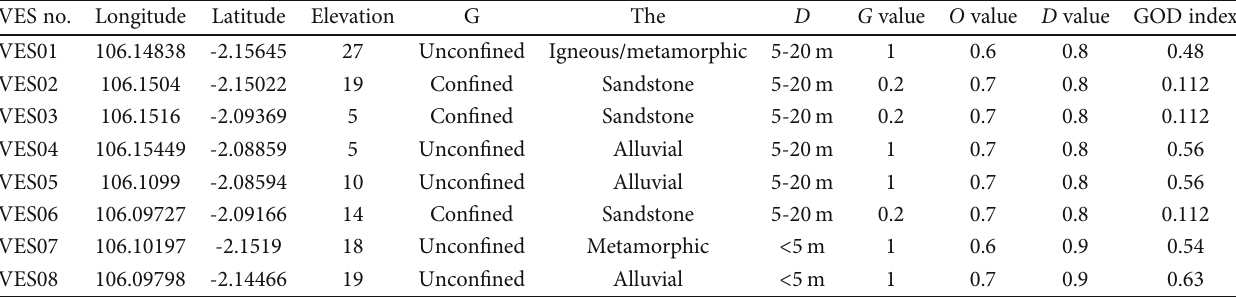
Table 9: Resume GOD method